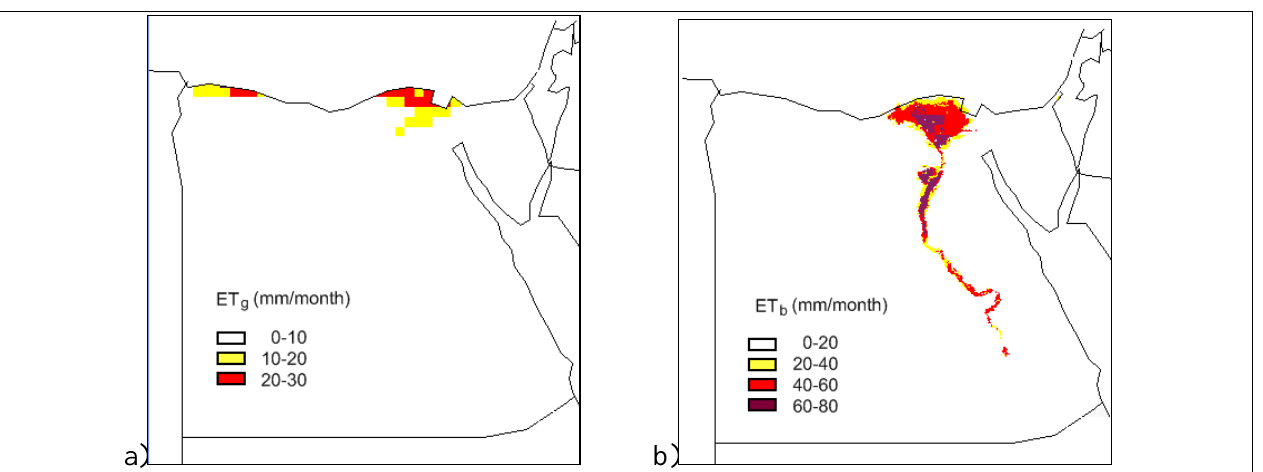
Figure 3. (a) Monthly green ET and (b) Monthly blue ET obtained in October 2009, using remote sensing data in